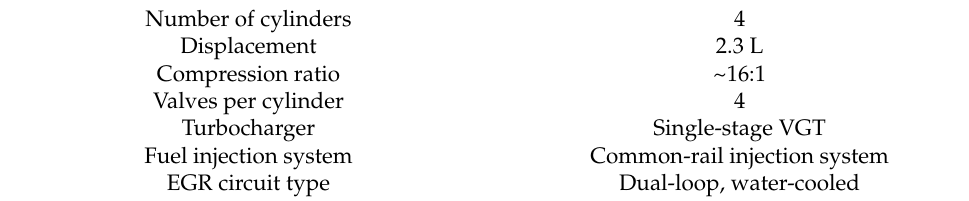
Table 1. Main technical specifications of the tested CI